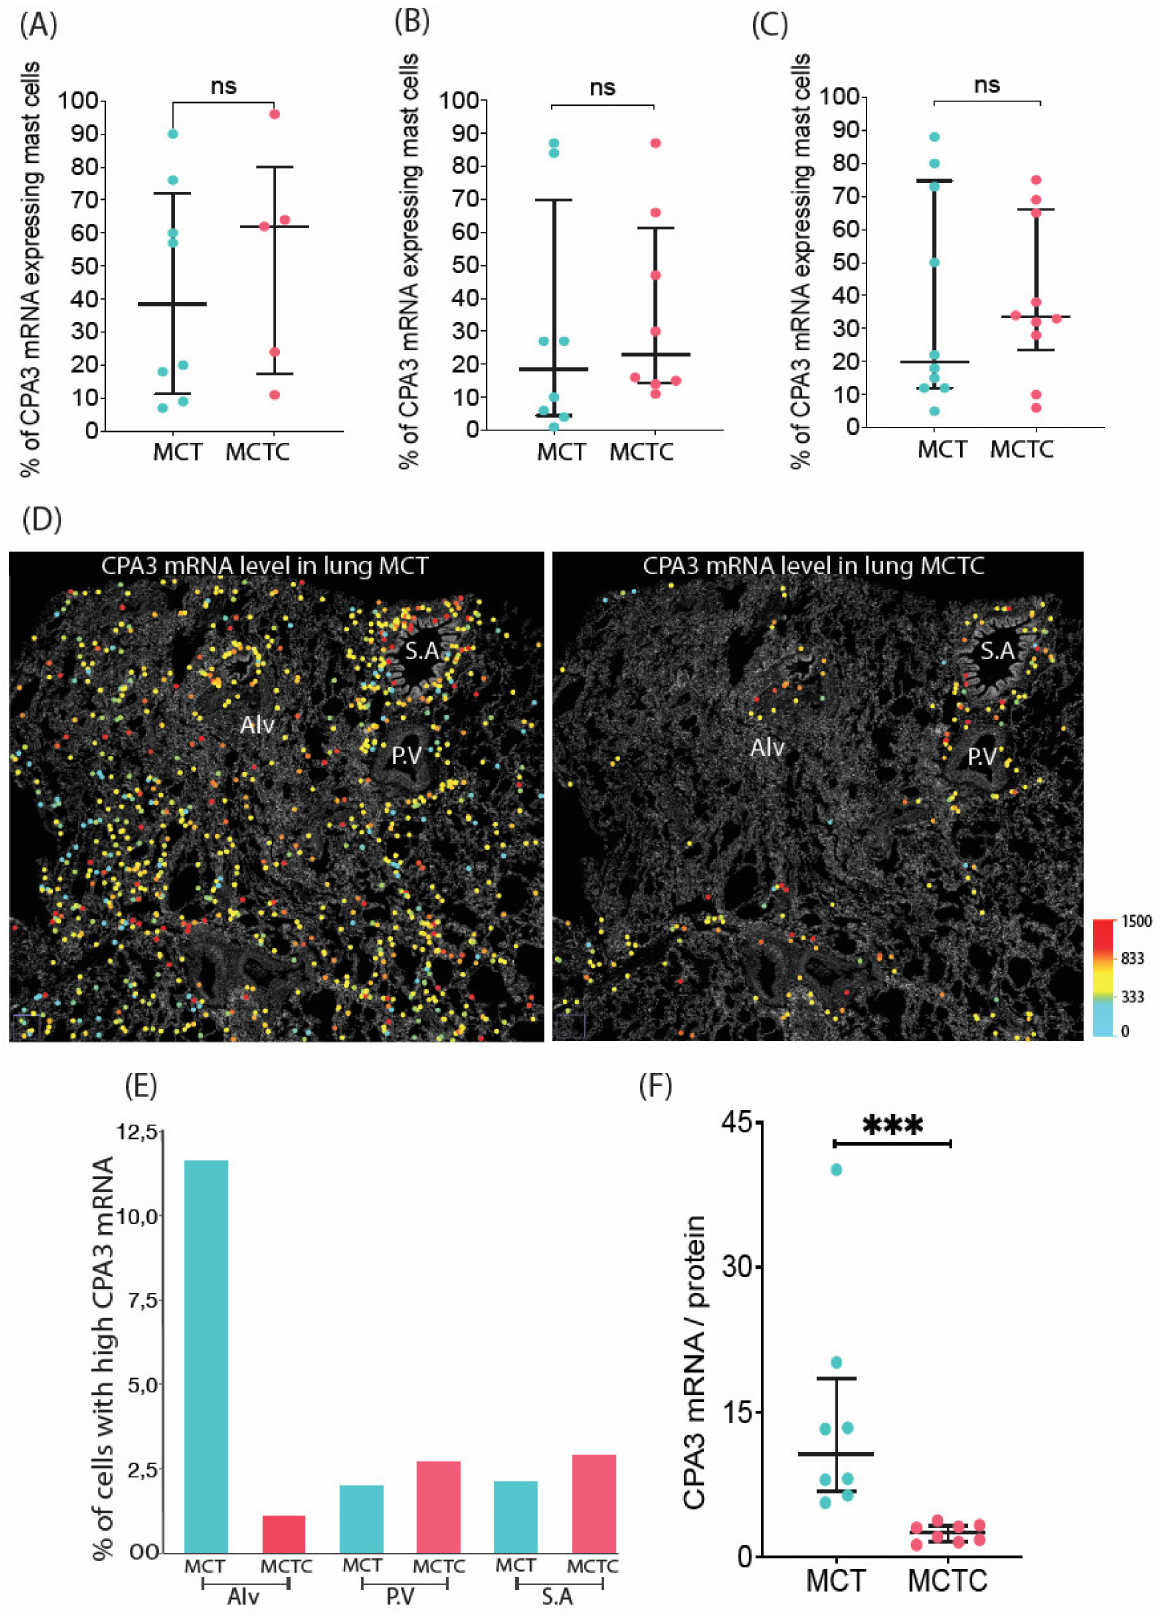
Figure 4. Quantification of CPA3 mRNA expressing mast cell subpopulations within lung anatomical regions. ( A – C )